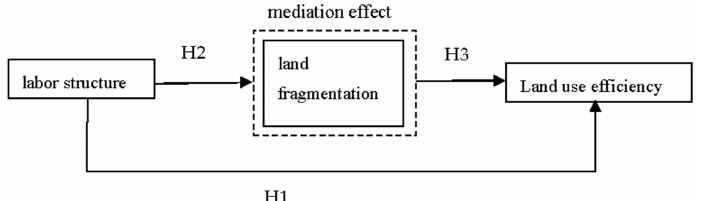
Figure 1. Analysis framework for the impact of labor structure and land fragmentation on land- use